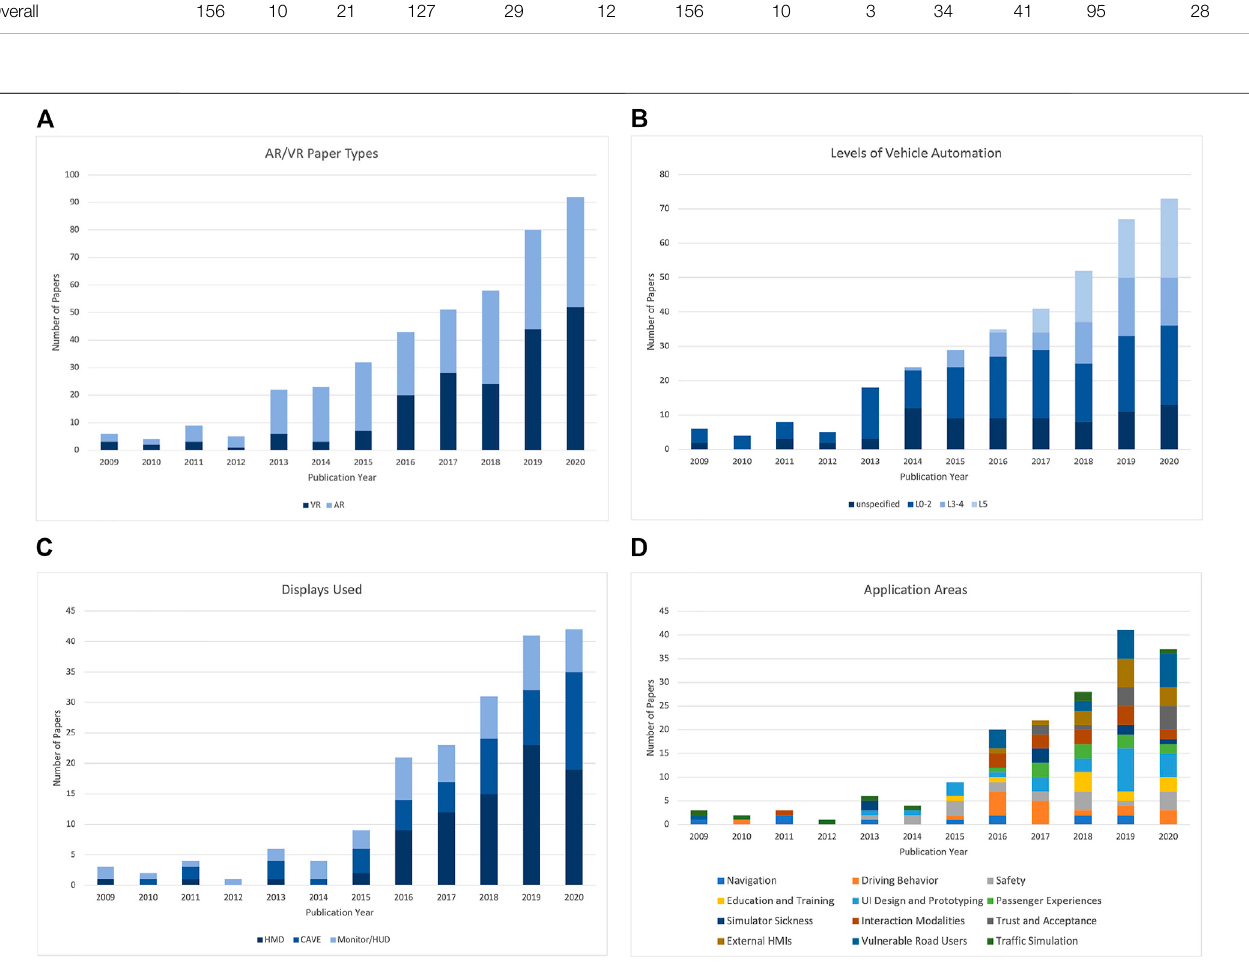
FIGURE 3 | High-level overview of the analyzed papers (A) AR/VR papers utilized in automotive research (B) Levels of vehicle automation (C) VR displays/devices used (D) Categorization of the papers into twelve application areas.